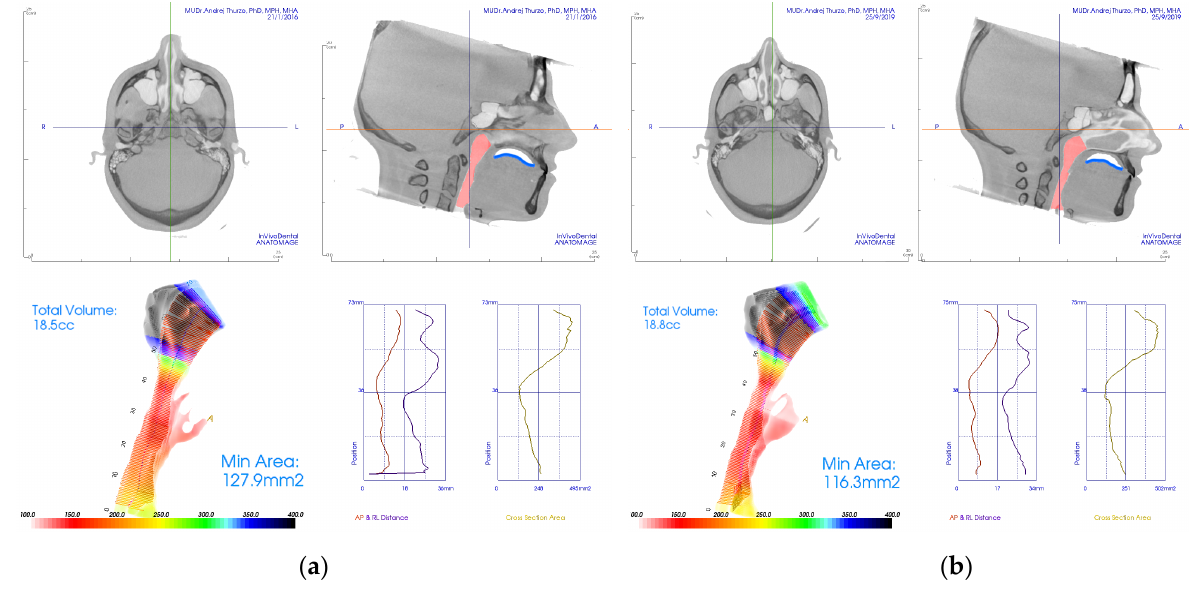
Figure 3. Examples of CBCT 3D analysis of the airway with evaluation of constriction in the software Invivo 6, from Anatomage (Santa Lara, CA, USA). ( a ) Pre-treatment CBCT with constriction; ( b ) post-treatment CBCT analysis with insignificantly improved airway constriction and unchanged tongue position.